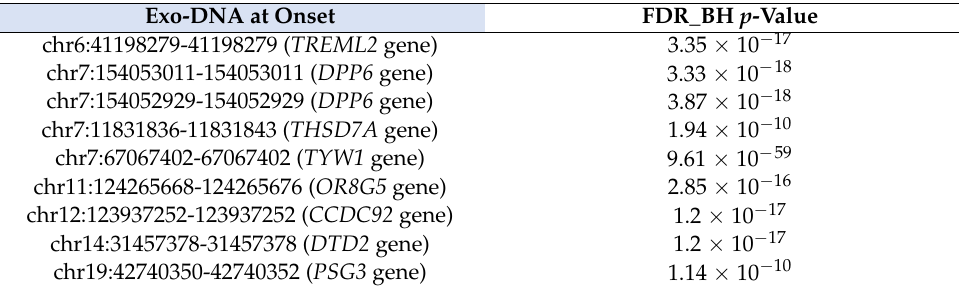
Table 5. Hotspot regions detected in exo-DNA at onset.